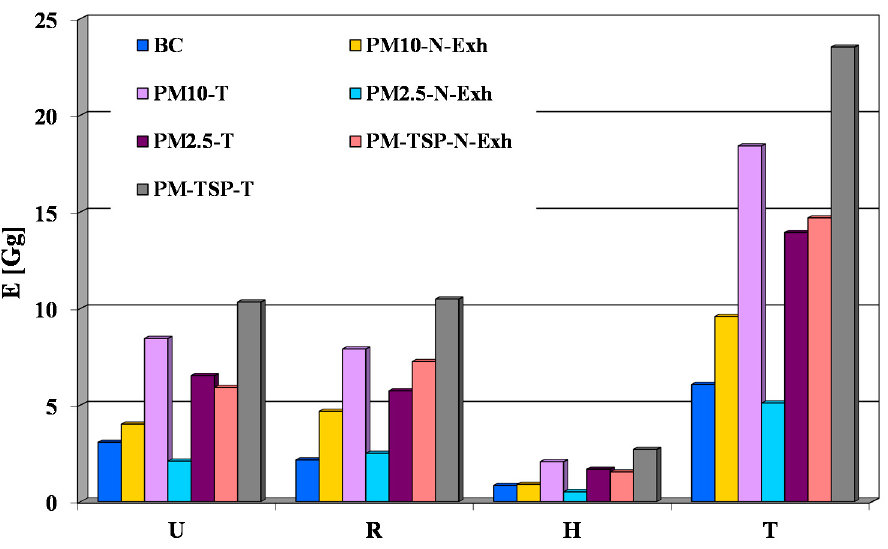
Figure 14. National annual emissions (E) of particulate matter from road transport under different traffic conditions: urban (U), rural (R), highway (H) and total (T).